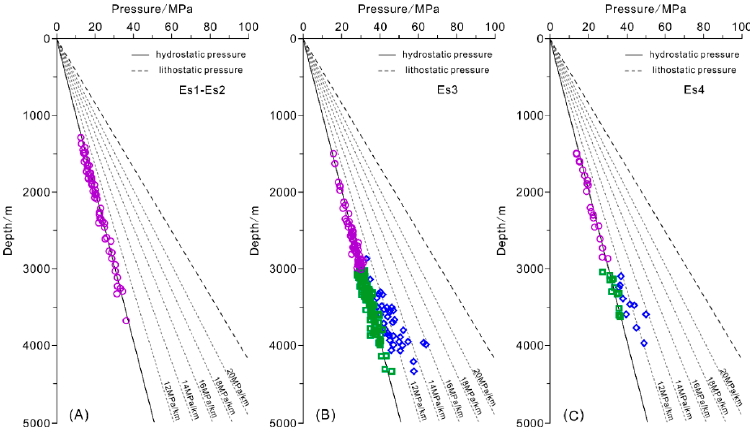
Figure 5. Plots of pressure versus depth for ( A ) Es1–Es2, ( B ) Es3, ( C ) and Es4 in the Linnan Sag. Overpressure developed in the Es3 and Es4. The measured pressure data were obtained from DSTs in wells. The sand bodies with normal pressure are either in hydrostatic environment (purple circle), or are laterally continuous or connected by faults (green square), while the sandstone that developed overpressure is mainly isolated sand bodies (blue diamond).